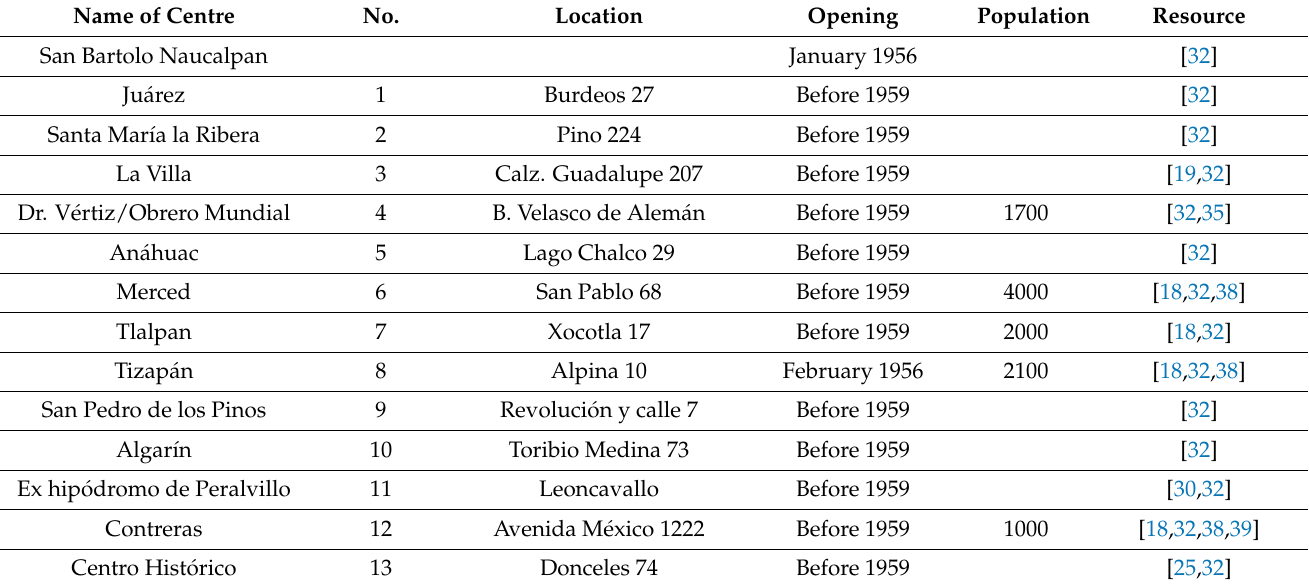
Table 2. Casas de la Asegurada in Mexico City between 1956 and 1959 according to [28].